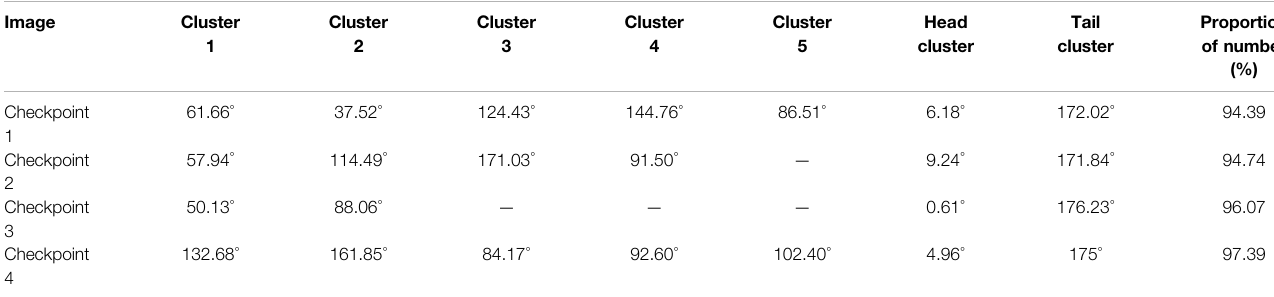
TABLE 4 | Mean angle and proportion of the number of lines in different